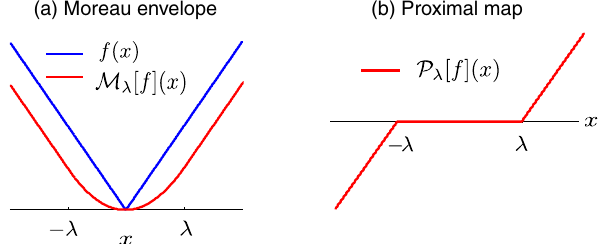
FIG. 2. (a) An example of a smooth, lower-bounding Moreau envelope M λ ½ f (cid:2)ð x Þ in Eq. (13) for f ð x Þ ¼ j x j . Explicitly, f (cid:2)ð x Þ ¼ ð x 2 = 2 λ Þ for j x j ≤ λ , and j x j − ð λ = 2 Þ for j x j ≥ λ . M λ ½ (b) The proximal map P λ ½ f (cid:2)ð x Þ in Eq. (12) for f ð x Þ ¼ j x j . Explicitly, P λ ½ f (cid:2)ð x Þ ¼ 0 for j x j ≤ λ , and x − sign ð x Þ λ for j x j ≥ λ . Thus, the proximal descent map x → P λ ½ f (cid:2)ð x Þ moves x towards the minimum of f ð x Þ .